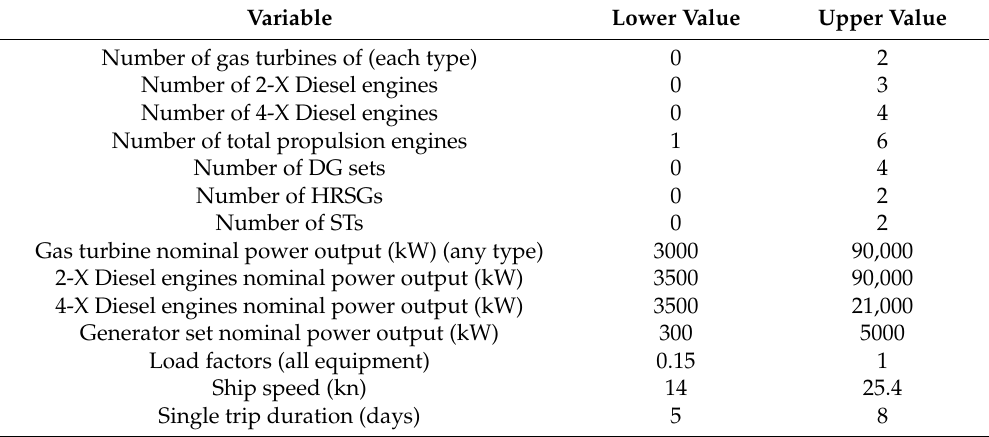
Table 24. Bounds on synthesis, design, and operation variables.